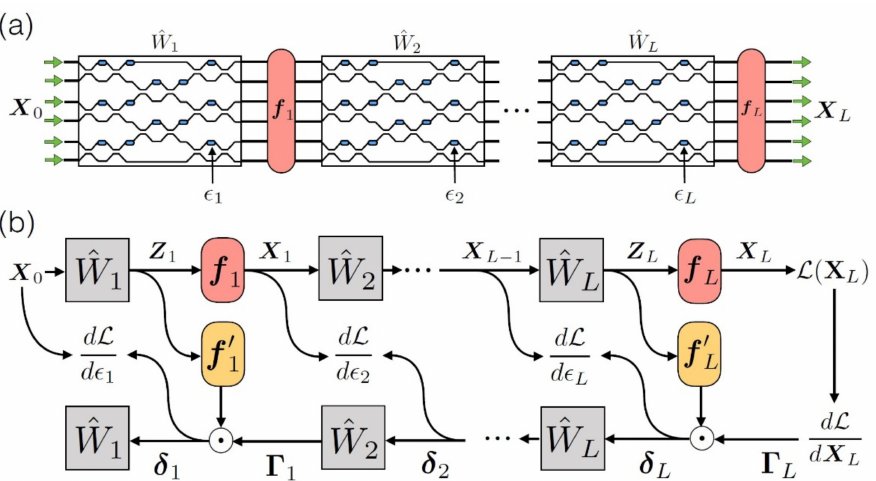
Figure 13. Backpropagation PNN. In stage ( a ), the squares correspond to the OIUs, which materialize the linear operation (matrixes W L ). In blue color, we see the integrated phase shifters for the control of OIU and the training of the network. The red areas correspond to the non-linear activation functions f L , which are performed through a computer. Respectively, in stage ( b ), the presentation of the operation for the calculation of NN ranks. The route on top corresponds to the anterior propagation and the bottom to the backpropagation [96].